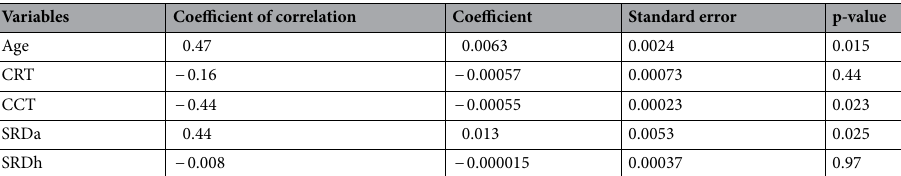
Table 2. Result of univariate analysis between logMAR best-corrected visual acuity (BCVA) and optical coherence tomography parameters. CRT central retinal thickness, CCT central choroidal thickness, SRDa area sum of all observed SRD regions (foveal and extra-foveal), SRDh SRD height at the fovea.